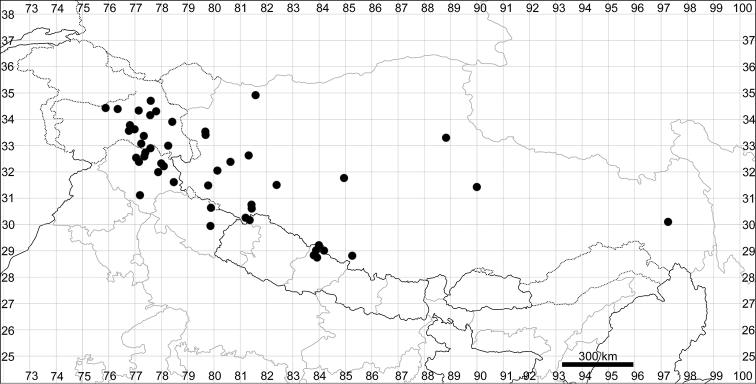
Distribution map of Krascheninnikoviaceratoides.